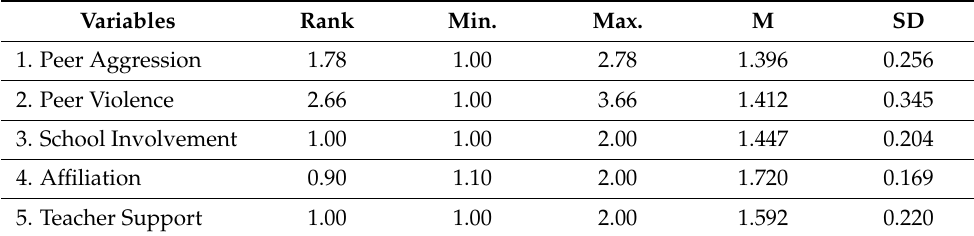
Table 1. Rank, minimum, maximum, and average values, and standard deviation. Variables